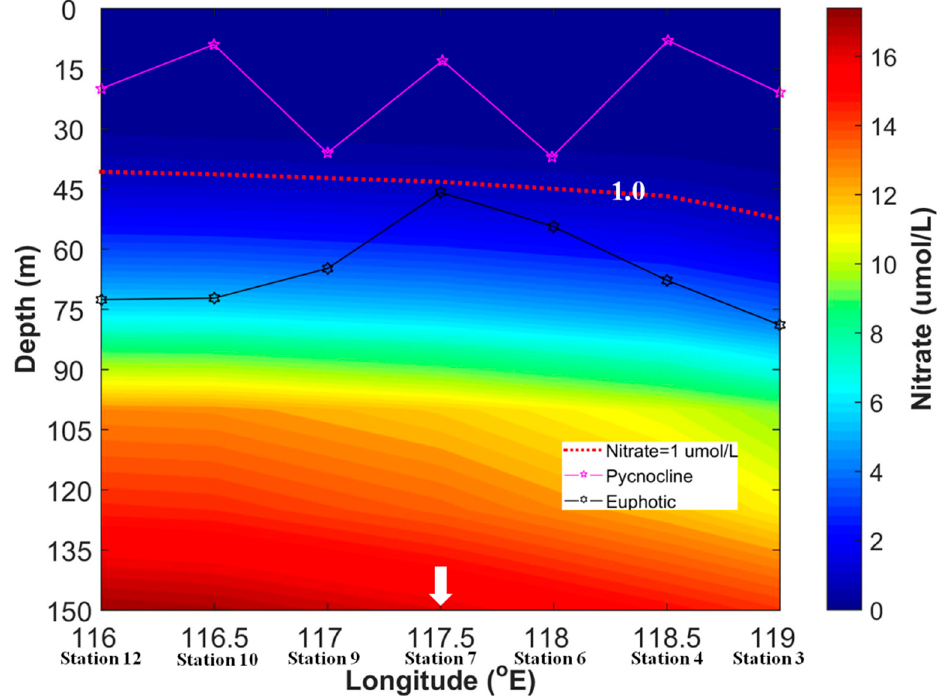
Figure 10. Monthly average nitrate distribution profile of WOA13 in June ( μ mol/L, the pink line with dots represents the MLD 1–2 days after the typhoon, the red dotted line represents the 1 μ mol/L of nitrate contour, the black line with dots represent the euphotic depth one week after the typhoon, the white arrow represents the center of the typhoon-induced cyclonic eddy).